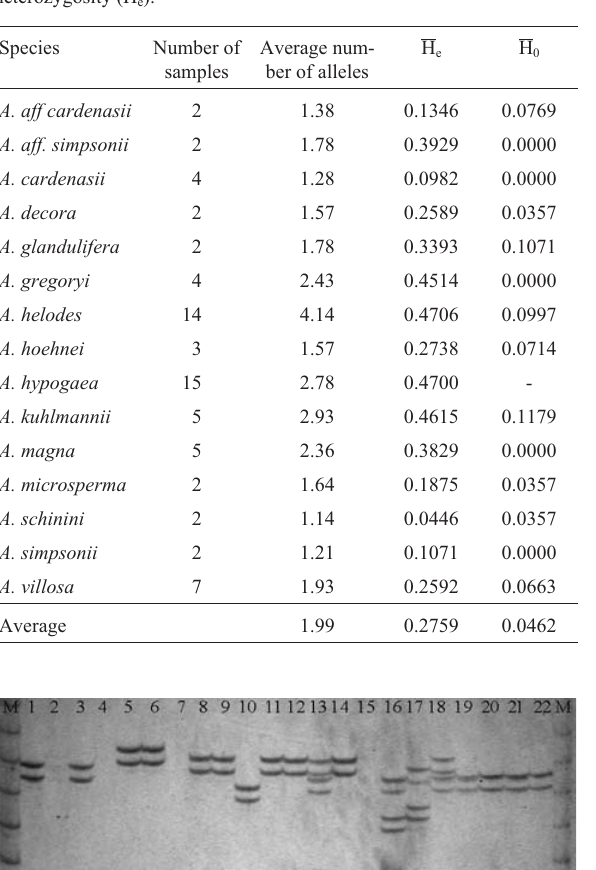
Table 4 - Number of samples analyzed, average number of different alleles per locus, mean observed heterozygosity (H 0 ) and mean expected heterozygosity (H e